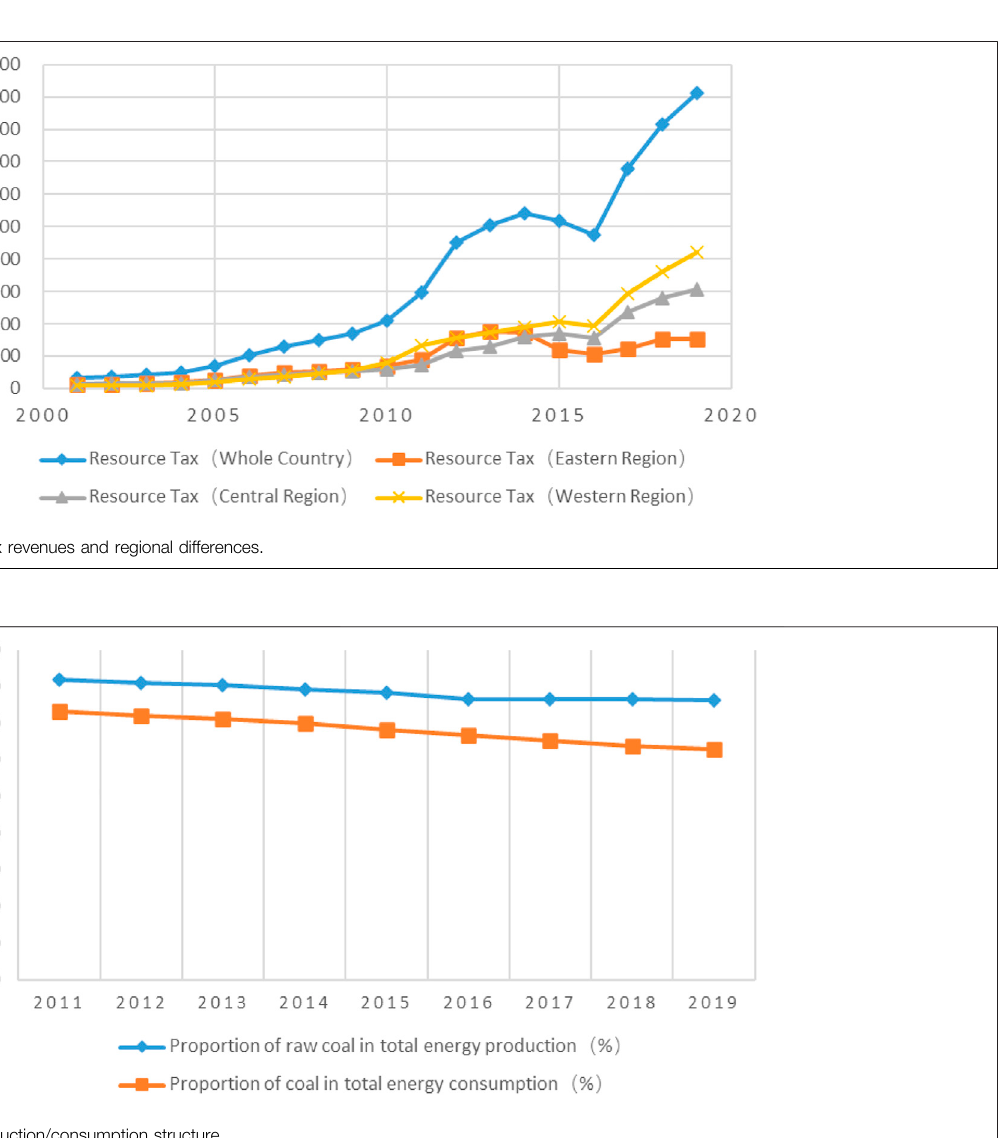
FIGURE 2 | China ’ s energy production/consumption